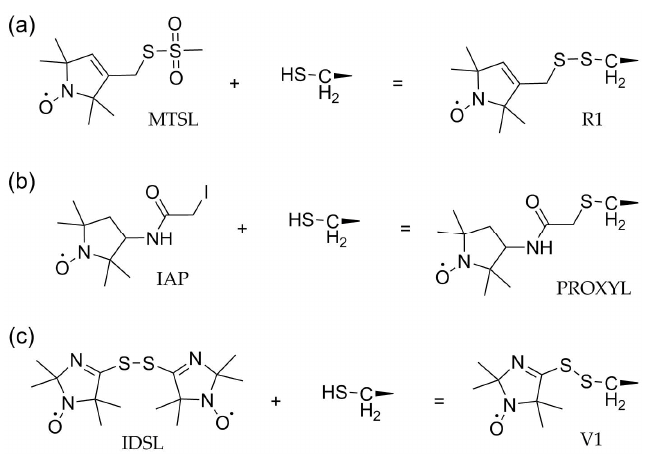
Figure 5. Spin labels commonly used for DEER. ( a ) MTSL: Reaction with the thiol side chain creates the disulfide-linked side chain R1. ( b ) IAP: S N 2 reaction creates the thioether-linked PROXYL side chain. ( c ) IDSL: Sulfhydryl-disulfide exchange leads to formation of the short spin label side chain V1.